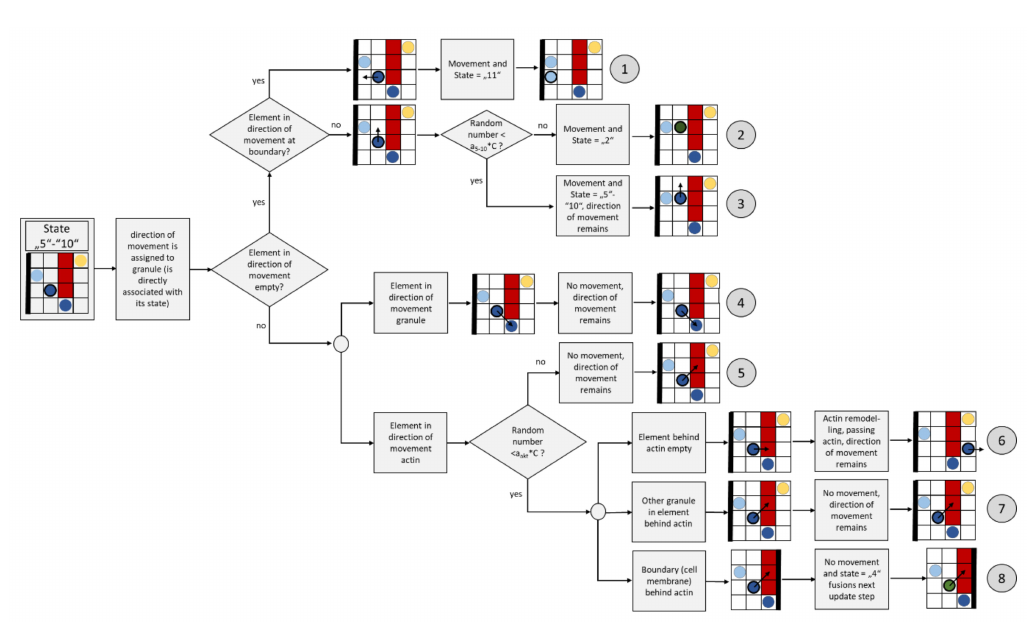
Figure 13. Flowchart for the update rule of a directed moving granule (states